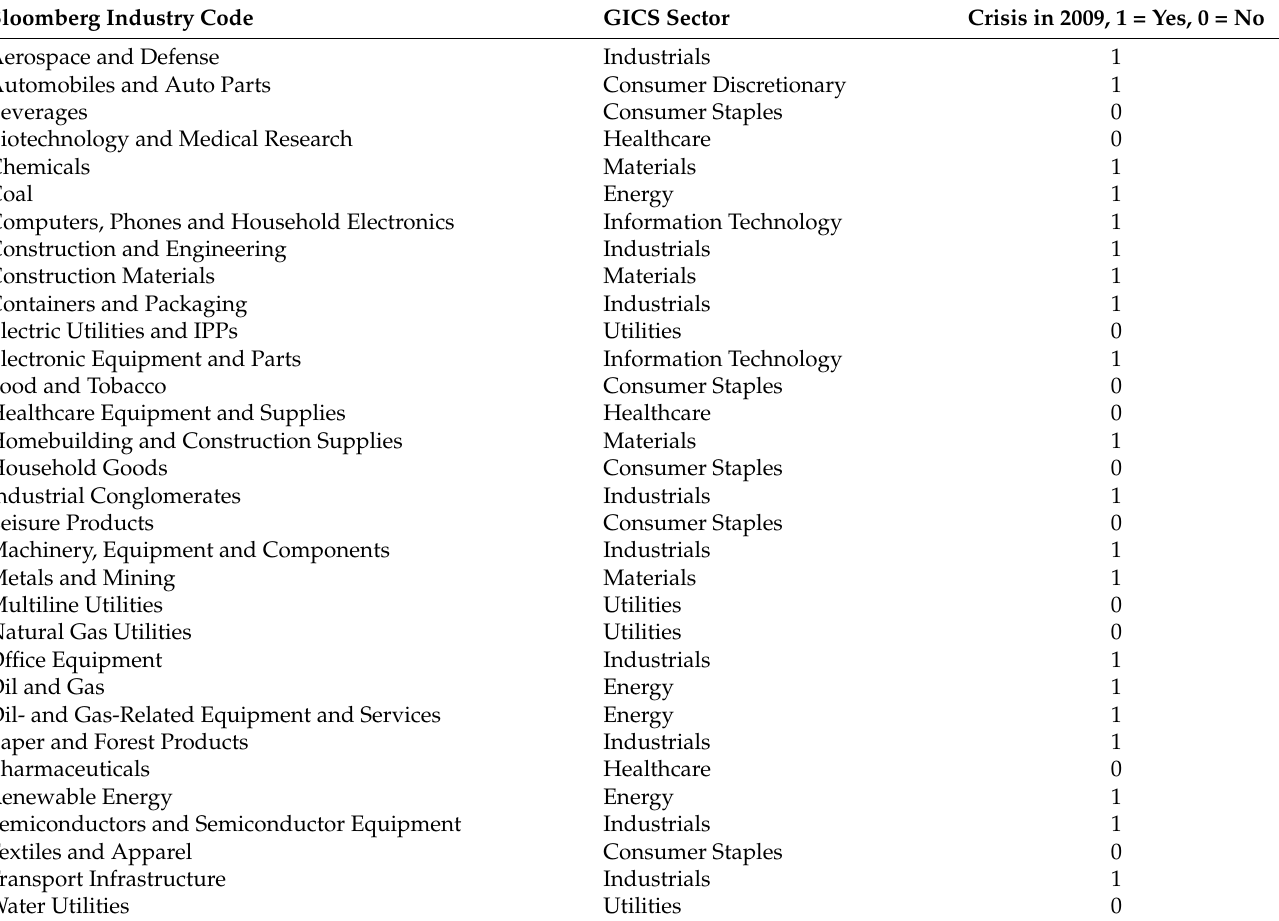
Table A1. Division of industries into GICS